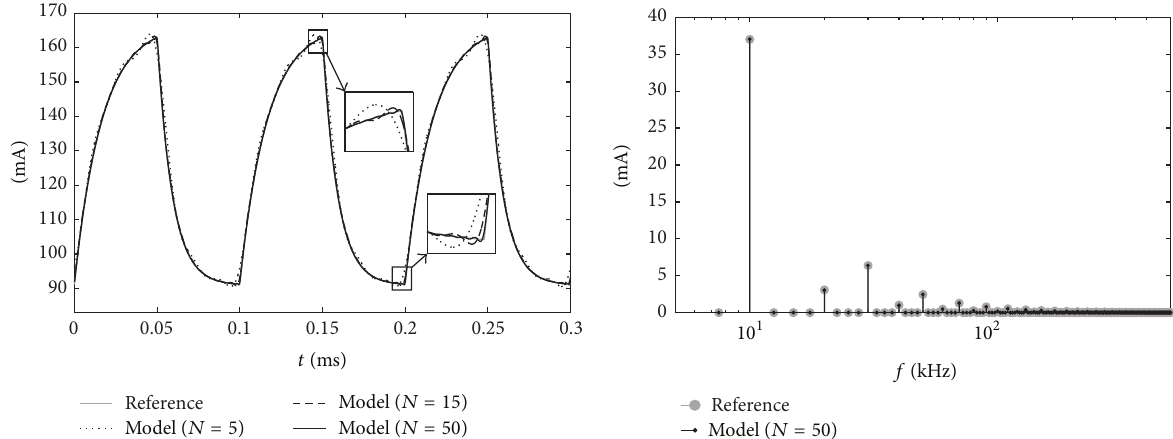
Figure 4: Time-domain (steady-state) responses of the current 𝑖(𝑡) for the circuit of Figure 3 and its corresponding frequency-domain spectrum. The reference time-domain response (computed by means of the ODE-based routines in MATLAB) is compared with the solutions arising from (29) and different values of the order of expansion 𝑁 .